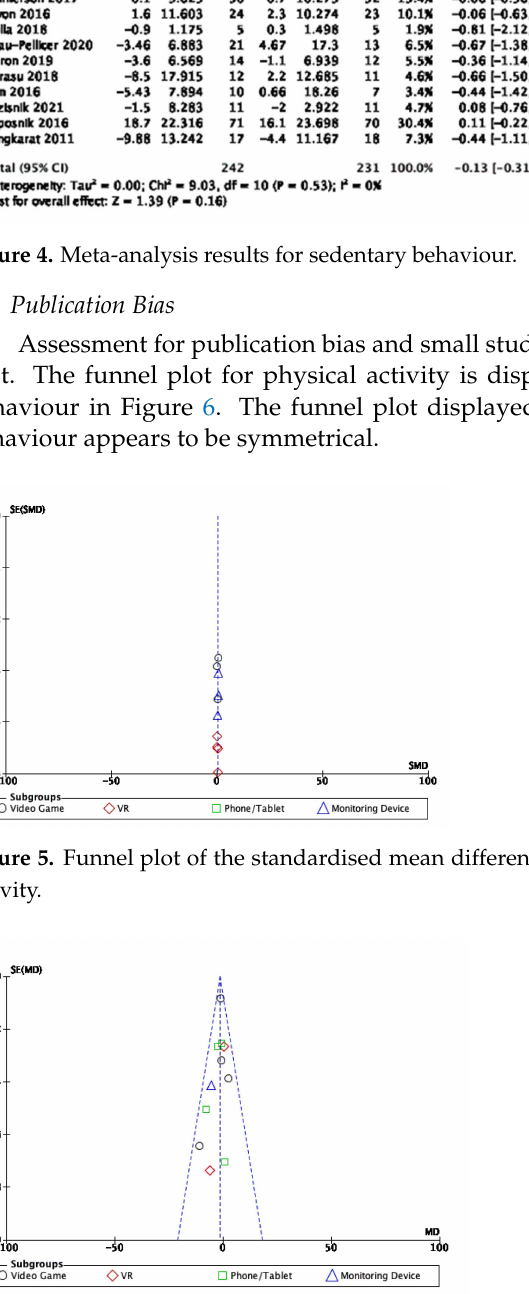
Figure 6. Funnel plot of the standardised mean difference against the standard error for sedentary